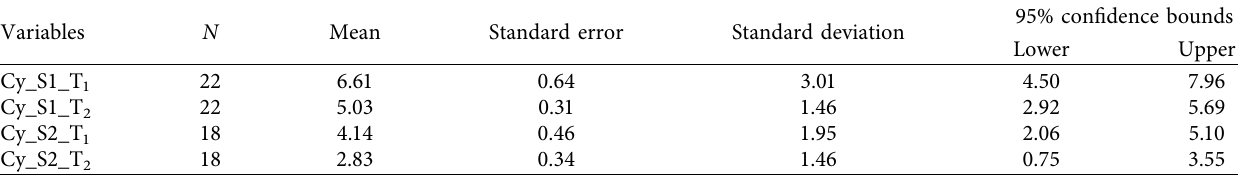
Bio_S2_T 2 Table 4: Descriptive statistics with confidence bounds for the crop yield (cy) data for seasons 1 and 2 with IT Variables